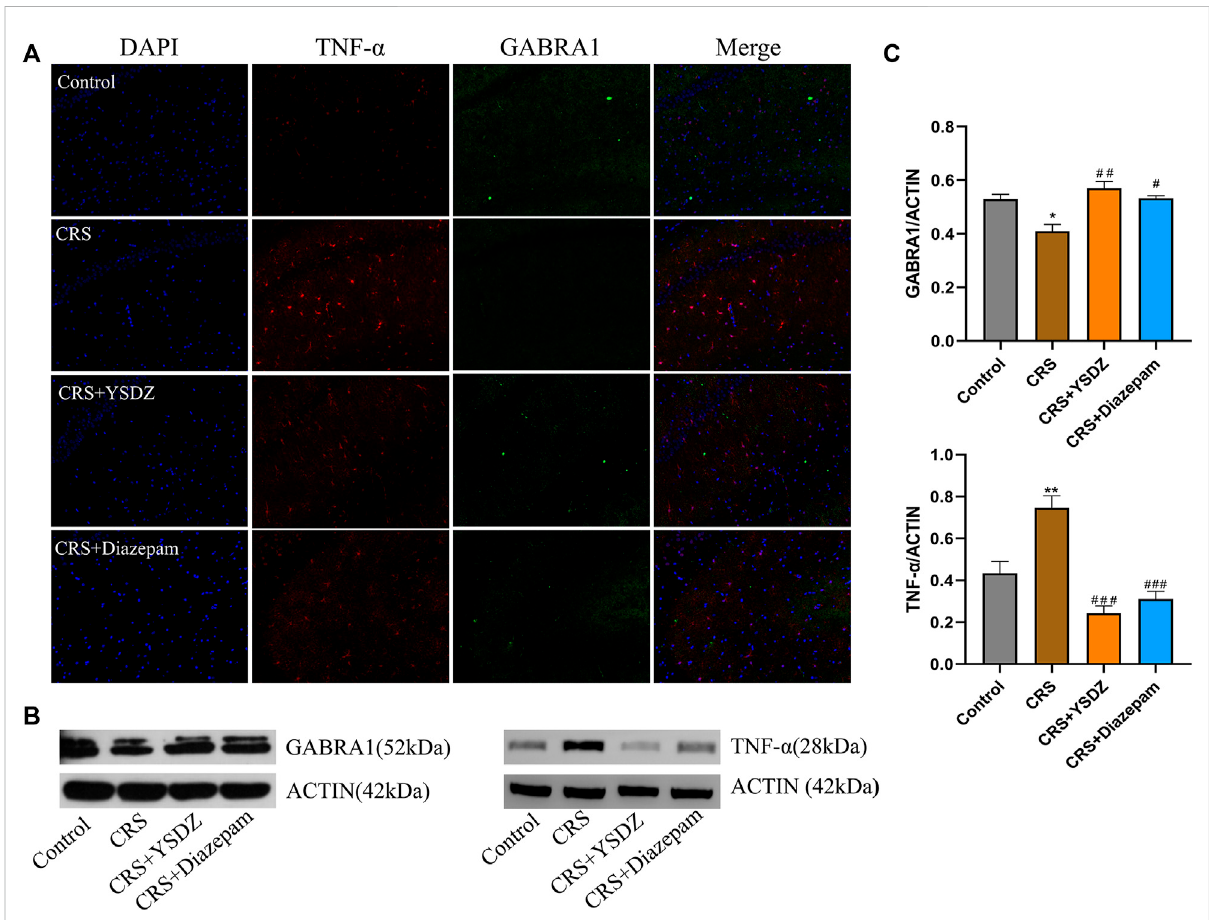
FIGURE 9 Verify protein expression. (A) Representative images of immuno fl uorescence staining of hippocampal slices for TNF- α (red) and GABRA1 (green); (B) Representative blots; (C) The protein expression levels of TNF- α and GABRA1 in WB. * p < 0.05, ** p < 0.01 compared with Control; # p < 0.05, ## p < 0.01, ### p < 0.001 compared with CRS via one-way